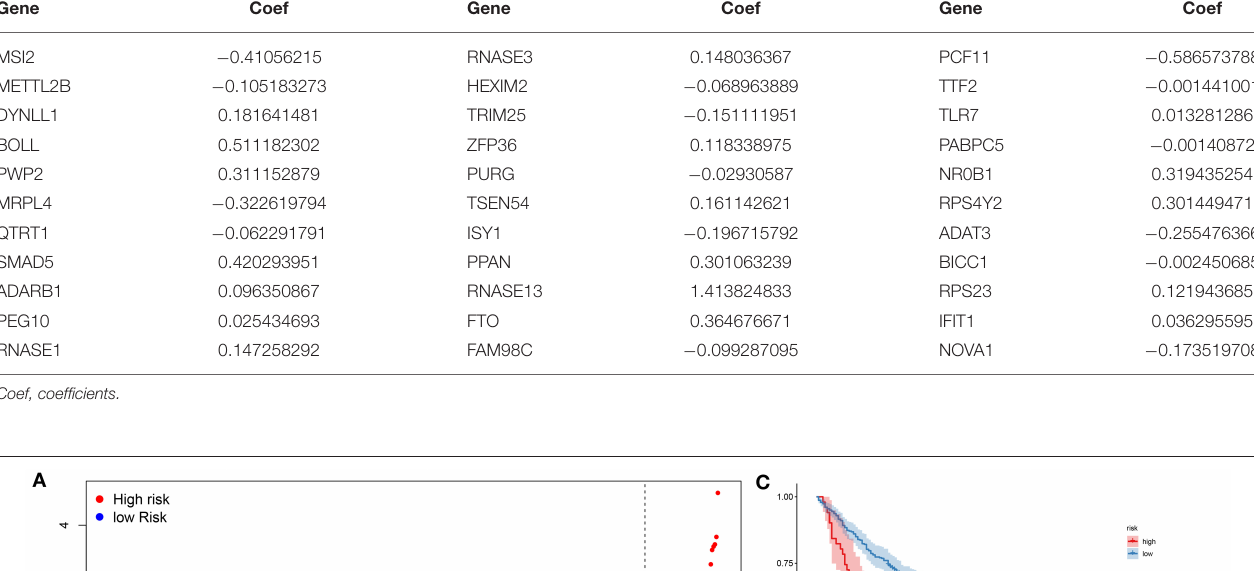
TABLE 2 | The coefficients of 33 key RBPs in the gene signature. Gene